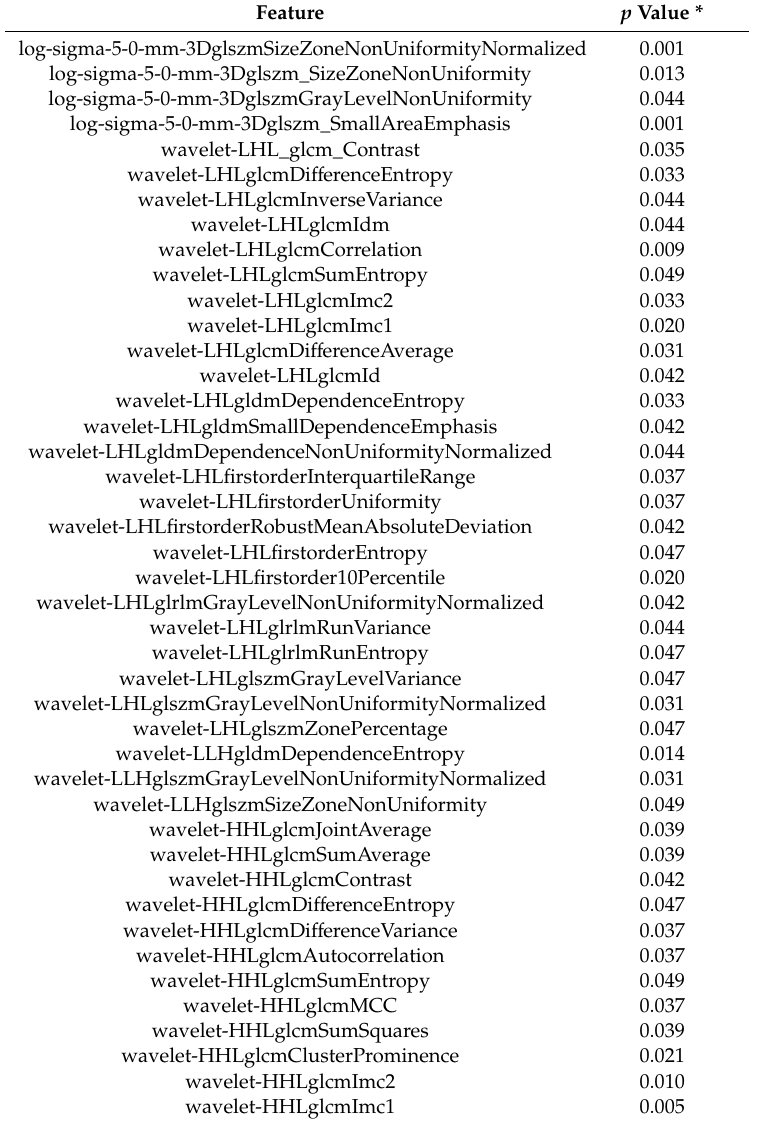
Table A1. List of selected radiomics features by univariate analysis for classification of non-responders vs.